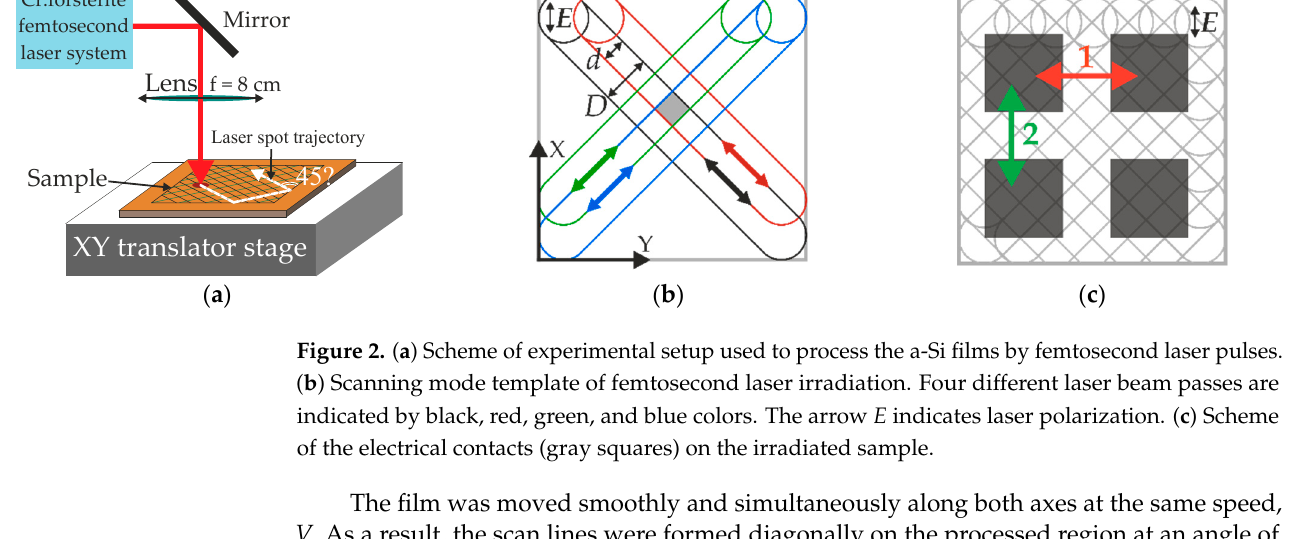
Figure 2. ( a ) Scheme of experimental setup used to process the a-Si films by femtosecond laser pulses. ( b ) Scanning mode template of femtosecond laser irradiation. Four different laser beam passes are indicated by black, red, green, and blue colors. The arrow E indicates laser polarization. ( c ) Scheme of the electrical contacts (gray squares) on the irradiated sample.